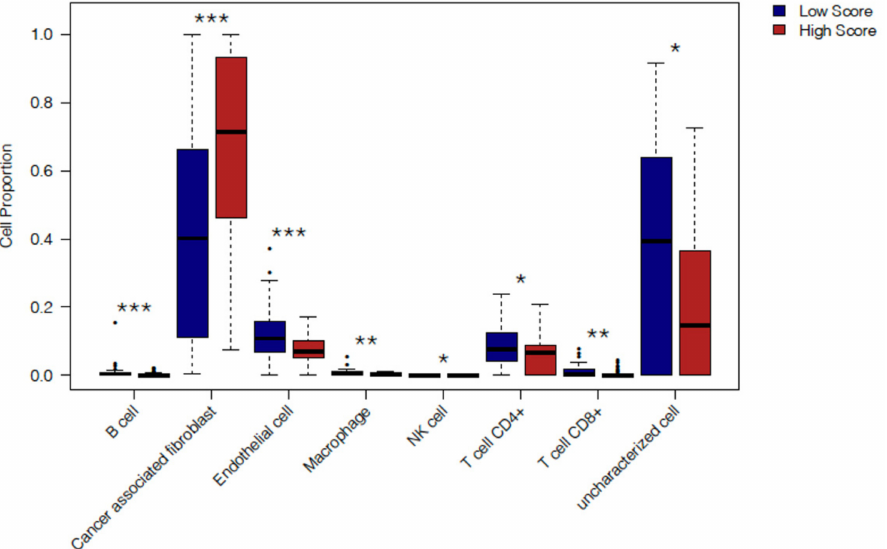
Figure 5. Cell type deconvolution of TCGA PDAC cases with High and Low Budding gene signature scores. Boxplots comparing the cell fractions as computed by the EPIC algorithm for immune and non-immune cells (B cells, CAFs, Endothelial cells, Macrophages, NK cells, CD4 + T cells, CD8 + T cells and uncharacterized cells) in High vs. Low Budding score cases ( n = 45 patients each) from TCGA. Data are shown as box and whisker plots with the box representing the IQR and the whiskers extending to the minimum and maximum values. Statistical comparisons between High and Low Score cases were performed for each immune cell subset individually using the Mann-Whitney U test. Only significant p values (<0.05) are shown on the graph. *** p < 0.001, ** p < 0.01, * p < 0.05.